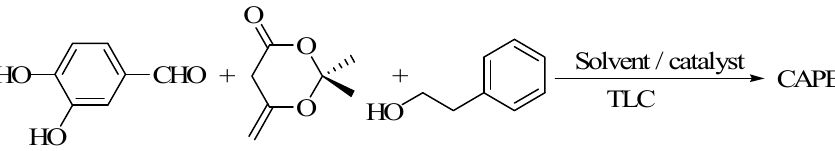
Figure 7. The scheme of method of one